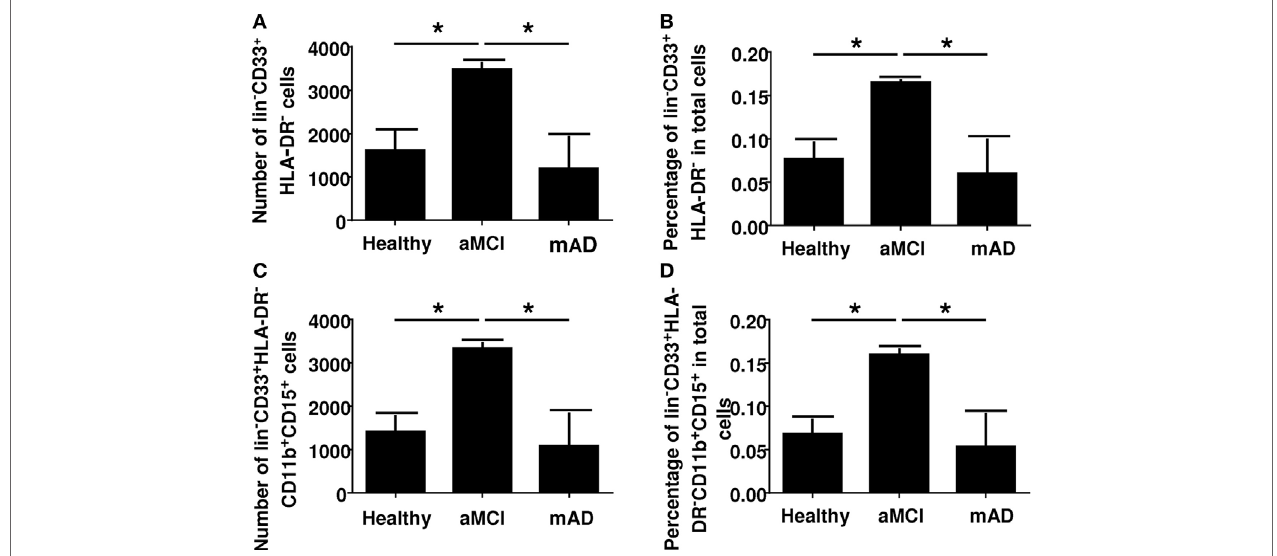
FigUre 1 | Determination of myeloid-derived suppressor cells number and percentage in whole blood of healthy, amnestic mild cognitive impairment (aMCI), and mild AD (mAD) subjects. (a) Number of CD33 + HLA-DR − cells in whole blood. (B) Percentage of CD33 + HLA-DR − cells in whole blood. (c) Number of CD33 + HLA- DR − CD11b + CD15 + cells in whole blood. (D) Percentage of CD33 + HLA-DR − CD11b + CD15 + cells in whole blood. Each group was composed of five independent subjects with determinations made in triplicate. Data are shown as the mean ± SEM. The asterisks (*) correspond to p <